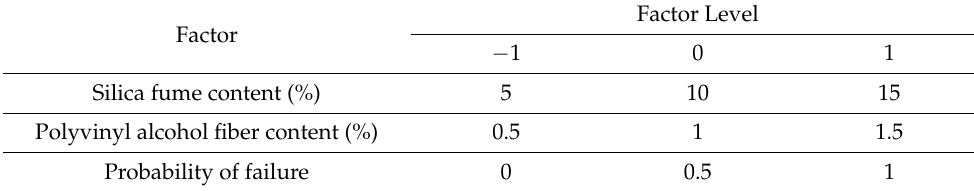
Table 8. Factor and factor